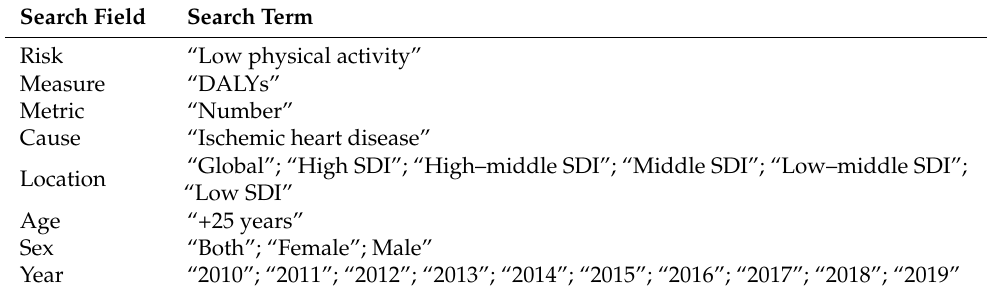
Table 1. Search criteria used in the 2019 Global Health Data Exchange (GHDx) database [14,15]. Search